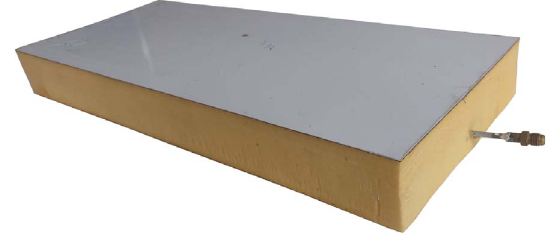
Figure 5. Example of segment (III) produced for bench test.